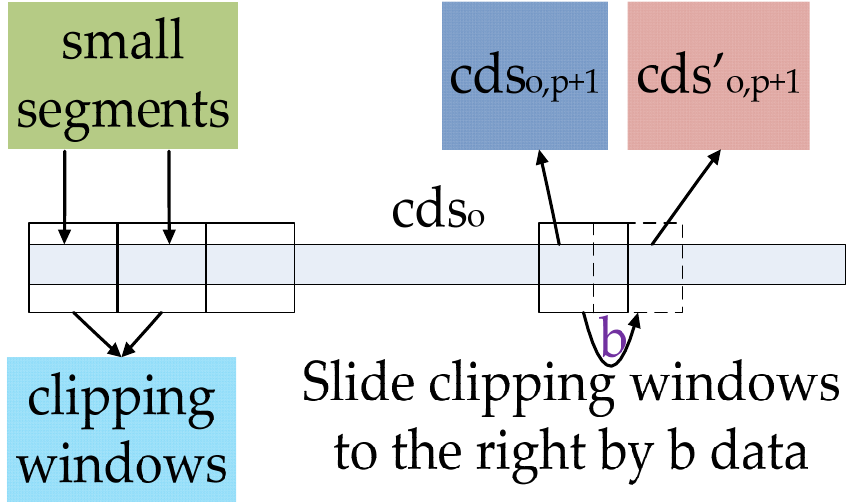
Figure 5. The process schematic diagram of sliding clipping window.